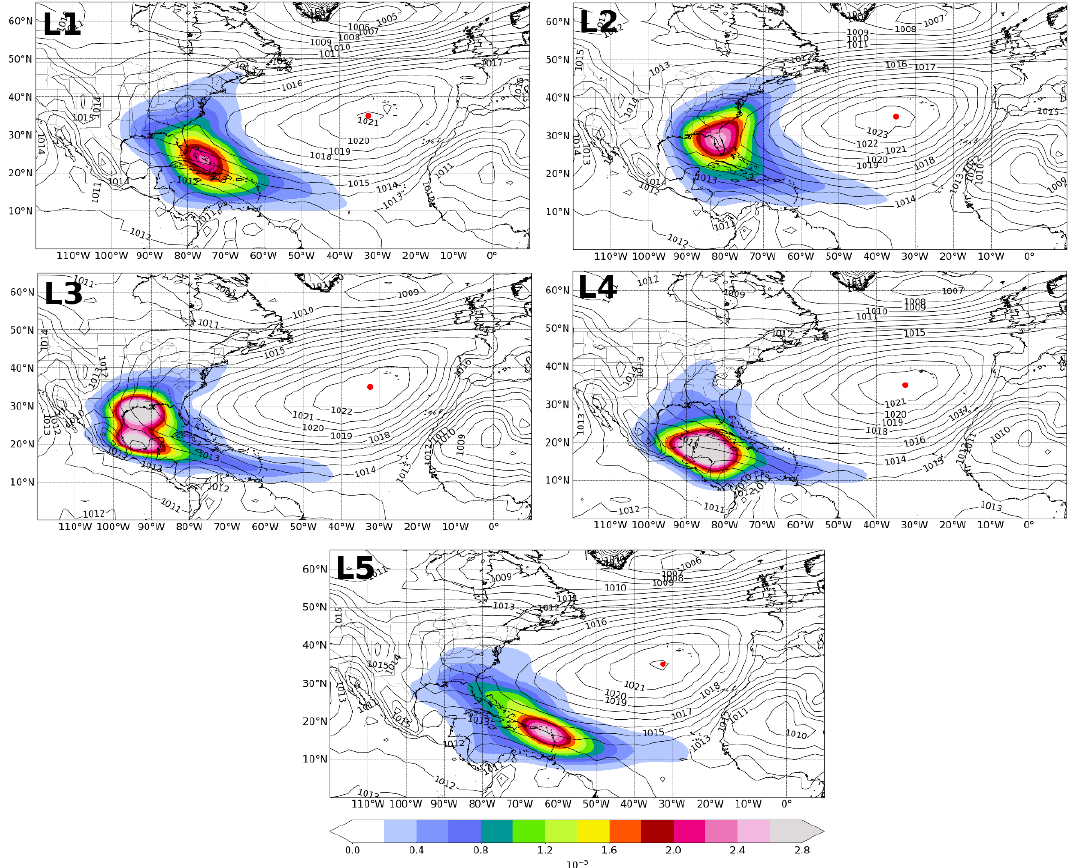
Figure 8. Kernel density estimation (KDE) for the trajectory of TCs that make landfall in each region. Contour lines represent the composite of mean sea level pressure for a specific month and specific year that landfalling events occurred. The red point and L N (N = 1, 2, 3, 4, 5) represents the NASH center and each landfalling cluster, respectively.